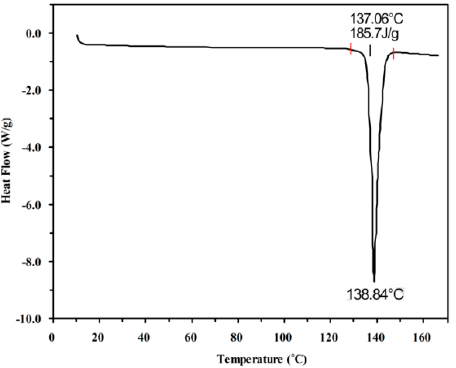
Figure 1. The differential scanning calorimetry (DSC) thermogram of metoprolol succinate.